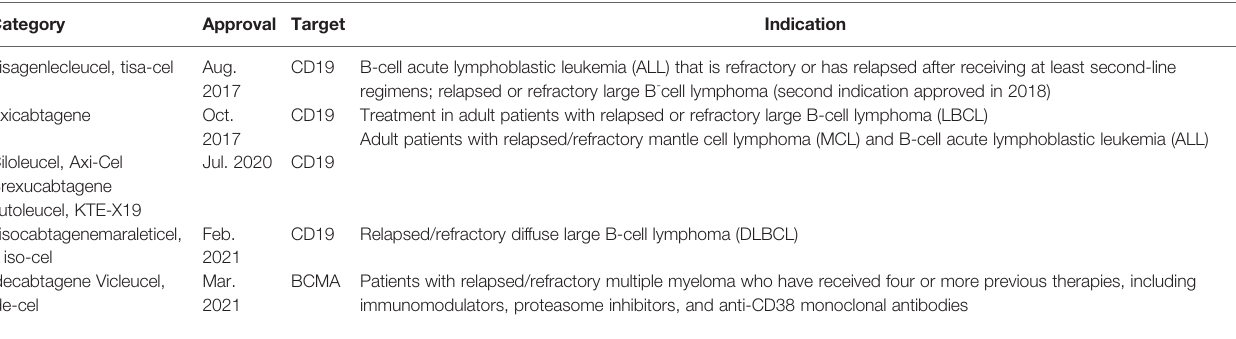
TABLE 1 | An overview of currently approved CAR-T